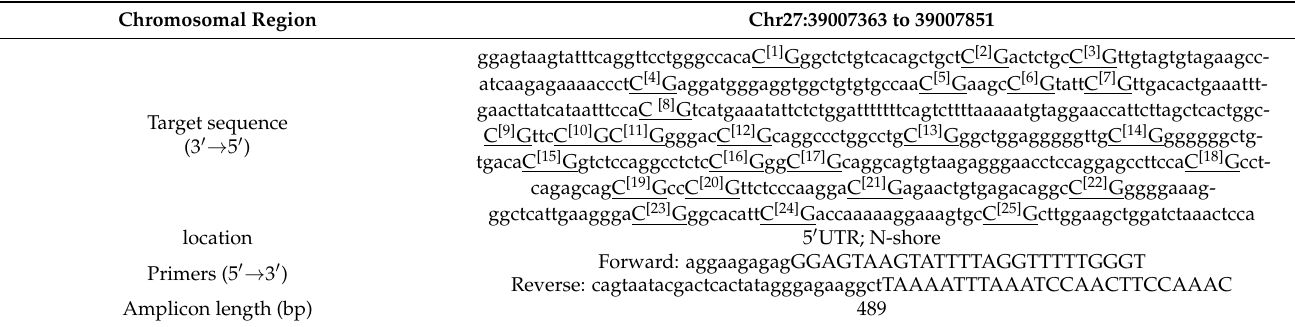
Table 2. PCR primers for ANGPT2 gene